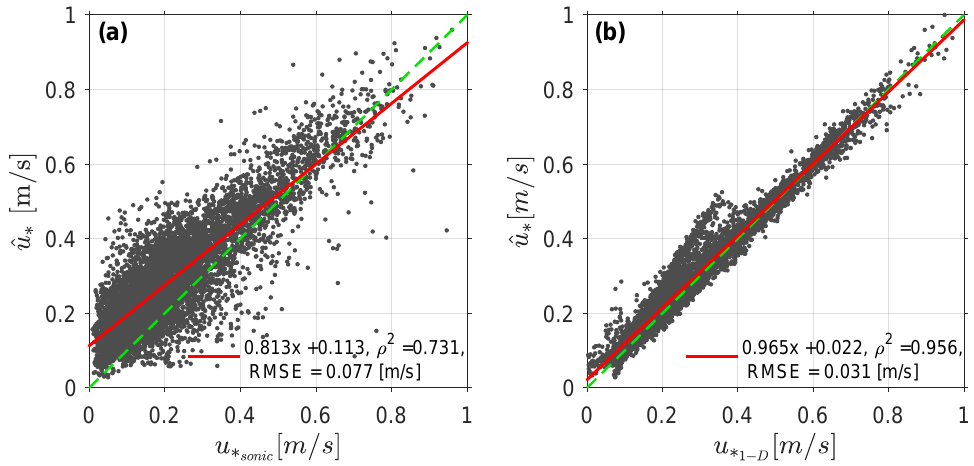
Figure 10. Scatter plot of the 2D-estimated friction velocity ˆ u ∗ against the two references provided